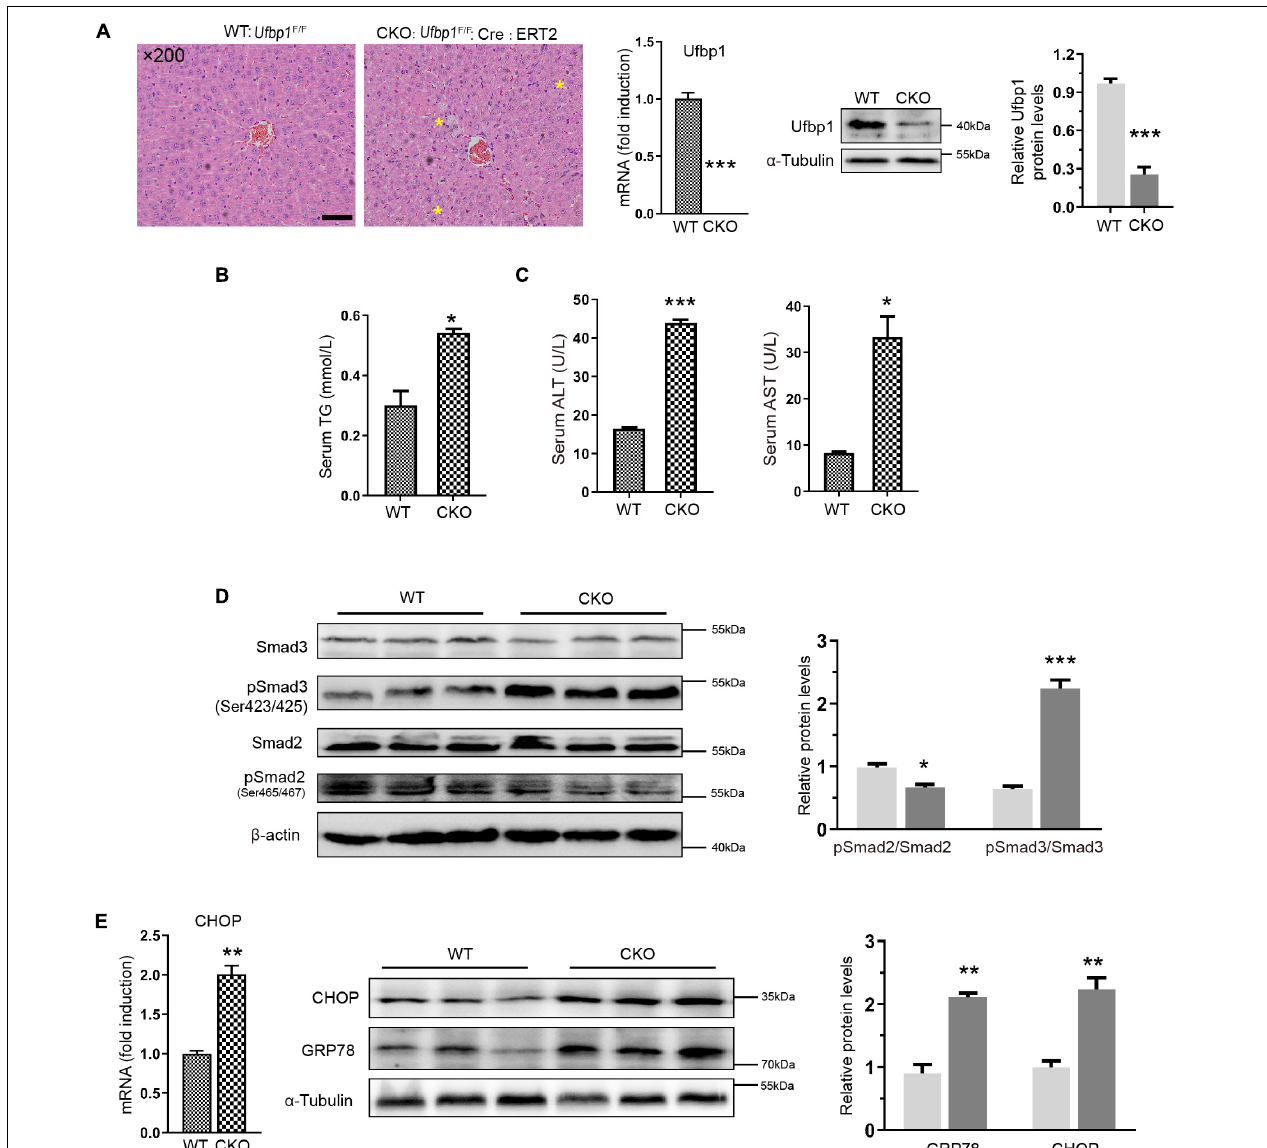
FIGURE 4 | Ablation of Ufbp1 led to Smad3 activation and elevated ER stress in conditional knockout mouse model. (A) H&E staining of representative liver tissues for WT and Ufbp1 CKO mice (mild hepatic steatosis identified by yellow stars), and Ufbp1 knockdown efficiency was detected by Western blot and RT-qPCR. (B) Serum triglyceride TG content ( n = 4). (C) Serum ALT and AST levels ( n = 4). (D) pSmad2 and pSmad3 expression was assessed by Western blot, and quantitative analysis was shown in right panel ( n = 3). (E) Expression of GRP78 and CHOP in liver tissues of CKO compared with WT ( n = 3). Data are presented as means ± SEM, * P < 0.05, ** P < 0.01, *** P < 0.001 ( n = 3). Scale bar = 50 µ